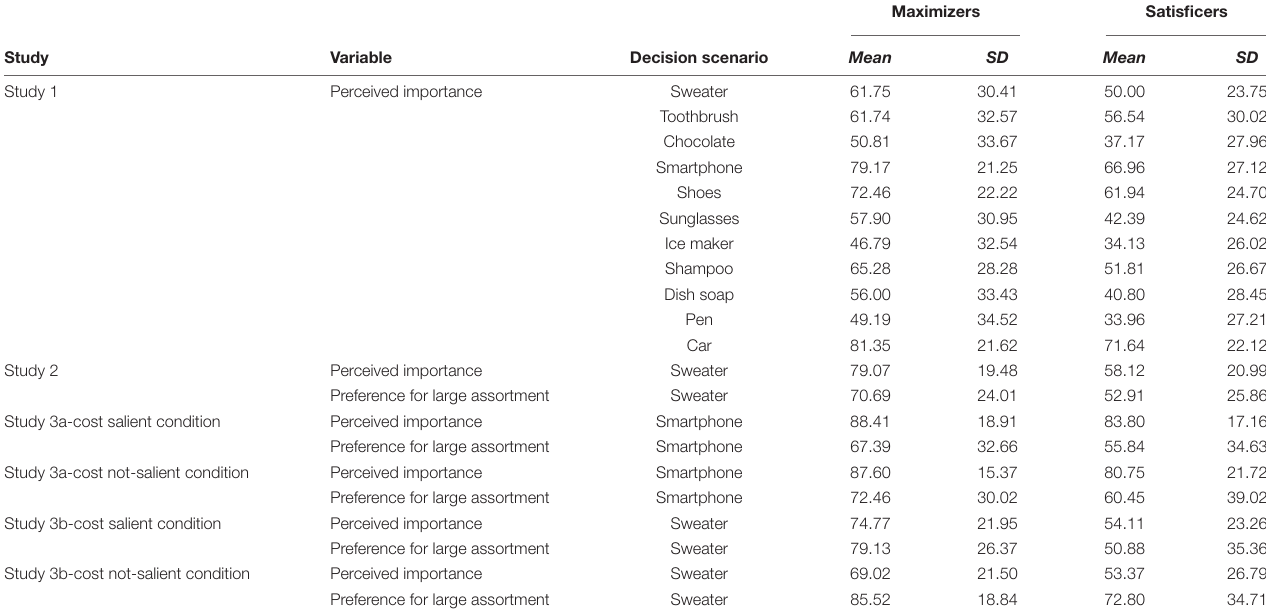
TABLE 1 | Descriptive statistics of all the four